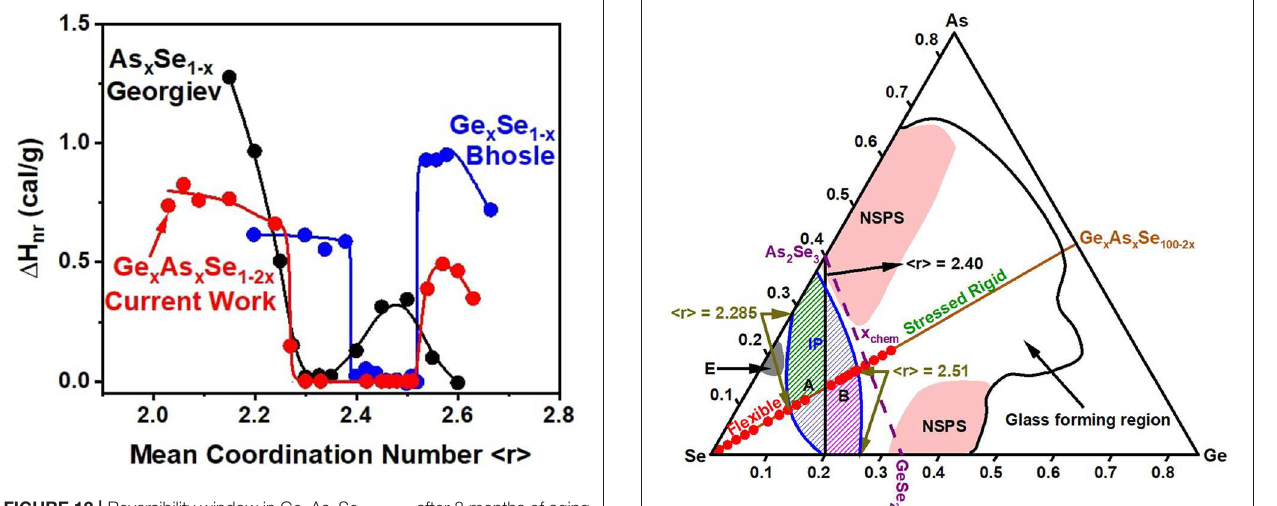
FIGURE 12 | Reversibility window in Ge x As x Se 100 − 2x after 8 months of aging compared to the windows in As-Se and Ge-Se binary glasses taken from Georgiev et al. (2000) and Bhosle et al. (2012b). FIGURE 13 | Topological phases observed in Ge x Se 100 − x binary (Bhosle